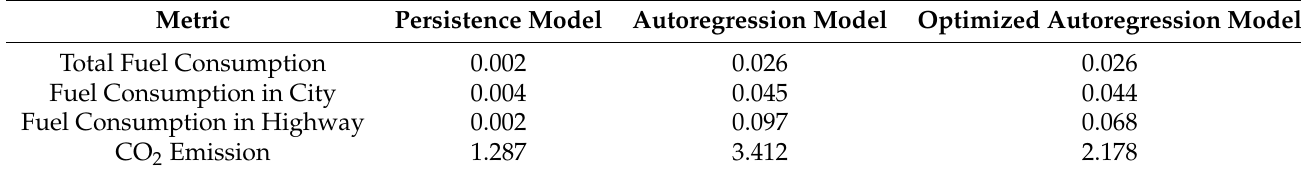
Table 11. Root Means Square Error (RMSE) of different regression